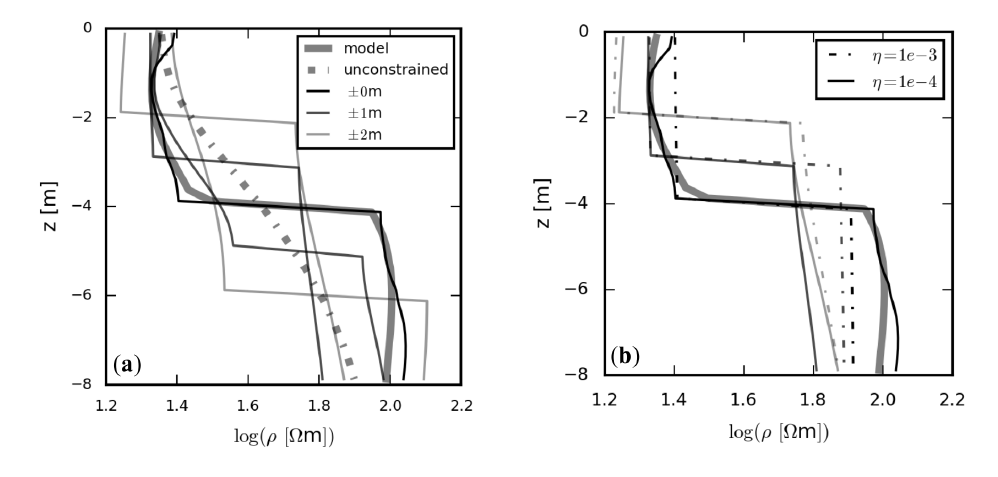
Figure 3. Resistivity along a depth profile in the grid center for misplaced structural constraints using: ( a ) η = 10 − 4 ; and ( b ) varied η .